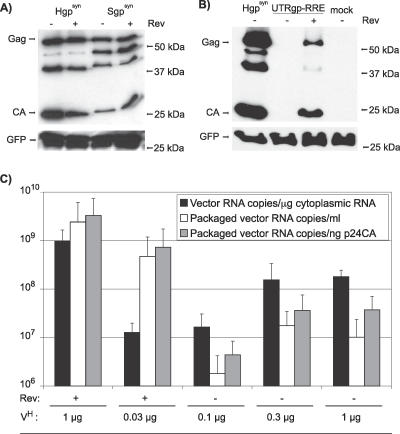
Effect of Rev on Gag-Pol Particle FormationViral particles were pelleted from the supernatant of cells transfected in the presence (+) or absence (-) of an HIV-1 rev expression plasmid with codon-optimized gag-pol expression plasmids of SIV (Sgpsyn) and HIV-1 (Hgpsyn) (A) or a wild-type HIV-1 gag-pol expression plasmid (UTRgp-RRE) (B). Western blot analyses were performed with pelleted particles and a CA-specific monoclonal antibody (upper panel). To control for transfection efficiency, a GFP expression plasmid had been included during transfection, and lysates of transfected cells were analyzed using an anti-GFP antibody (lower panel).(C) Cytoplasmic and particle-associated vector RNA copy numbers were determined in cell cultures transfected with different amounts of the VH vector plasmid in the presence or absence of Rev expression plasmid. In addition, pelletable p24CA levels were determined and used to calculate the packaging efficiency as particle-associated vector RNA copies per nanogram p24CA.